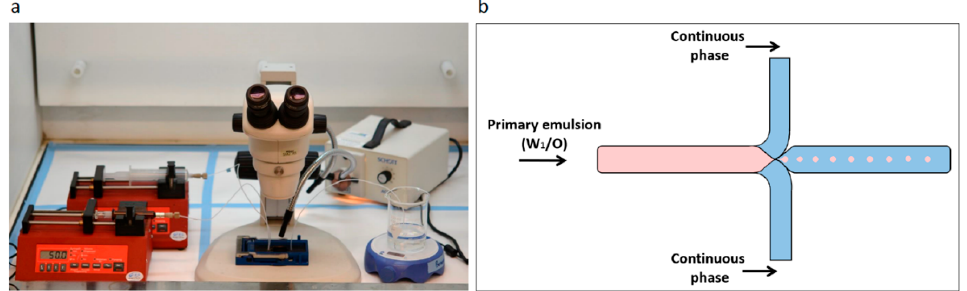
Figure 1. Microfluidics system for preparation of porous microspheres (MPs) with varying properties.